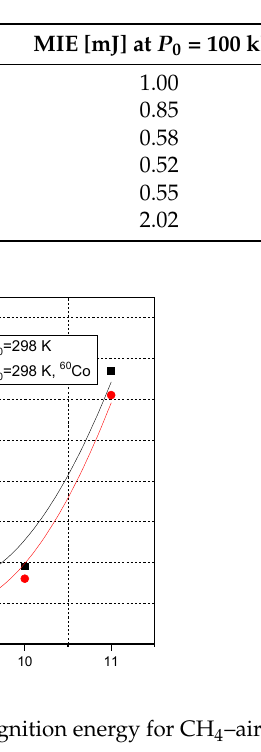
Table 3. Experimentally determined minimum ignition energies in the explosion cell with a volume of 0.17 L, with Φ /h = 1, by varying the initial pressure and the concentration of CH 4 in the presence of 60 Co radioactive source.